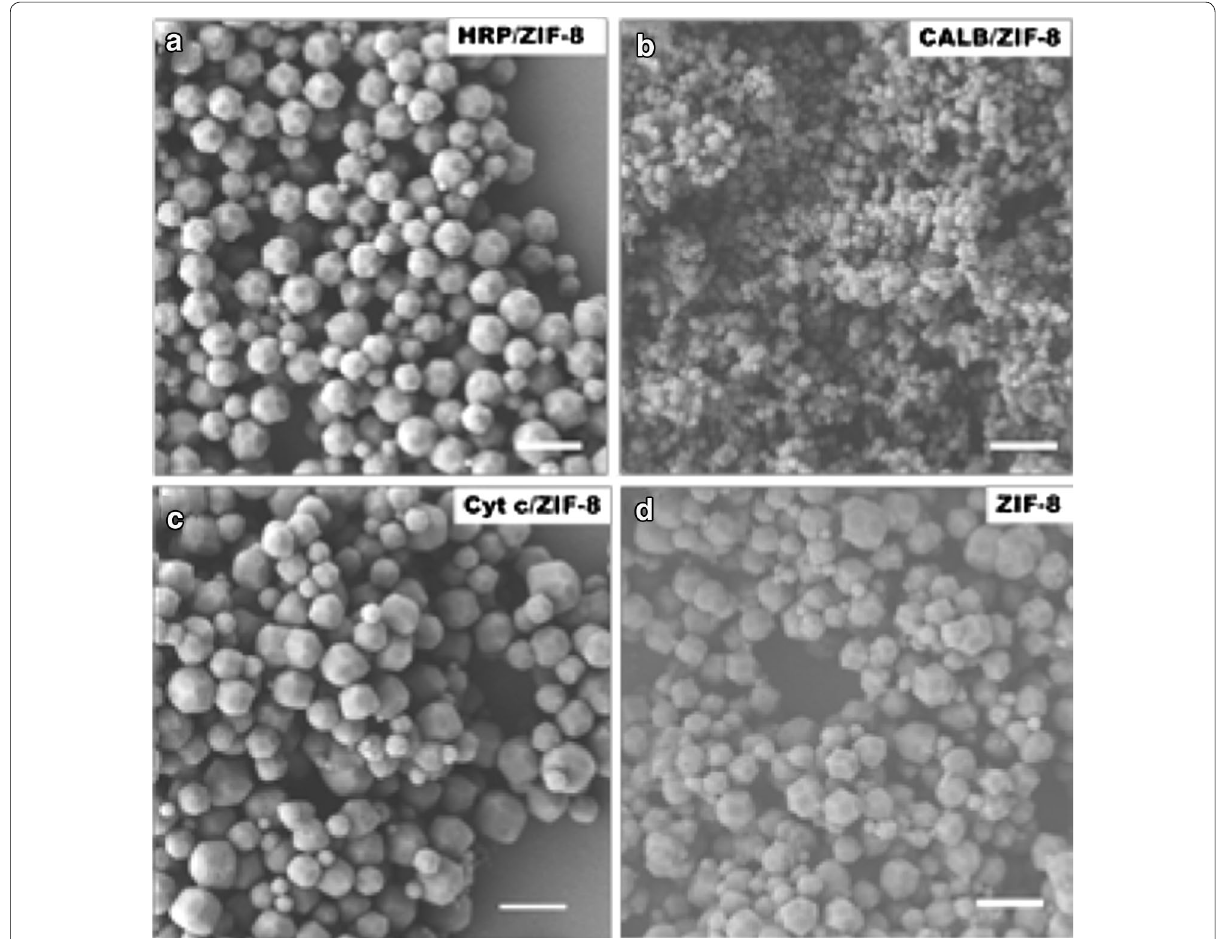
Fig. 2 SEM images of a HRP/ZIF-8, b CALB/ZIF-8, c Cyt c/ZIF-8, and d ZIF-8. Scale bars 1